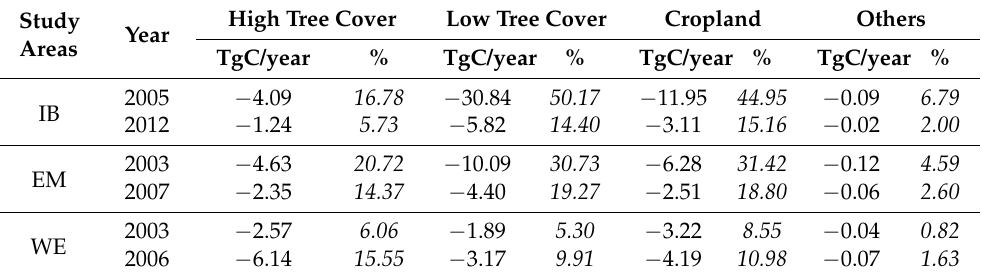
Figure 7. As in Figure 5, but over WE for 2003. Table 4. Annual productivity balance of each land cover class, in TgC/year. The percentage of each affected land cover type of the region is also represented on italic